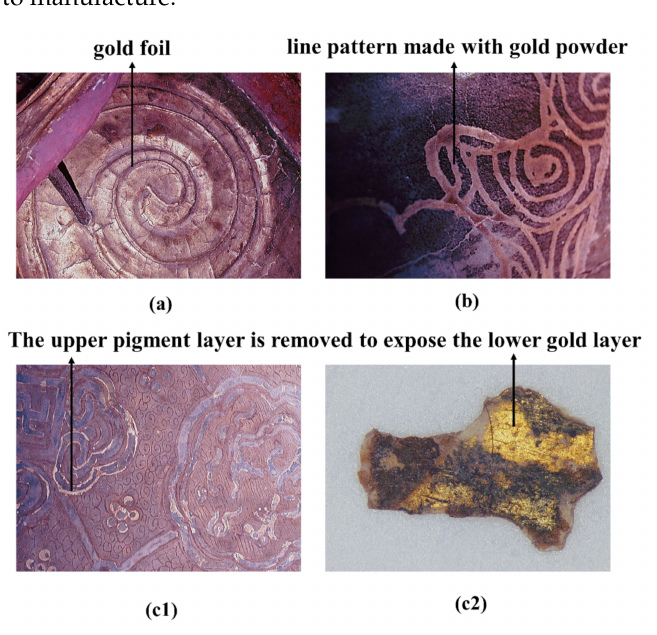
Figure 8. Digital microscopy (DM) of “gilding technique”: ( a , b , c1 ) in situ microphotographs; ( c2 ) flaked sample